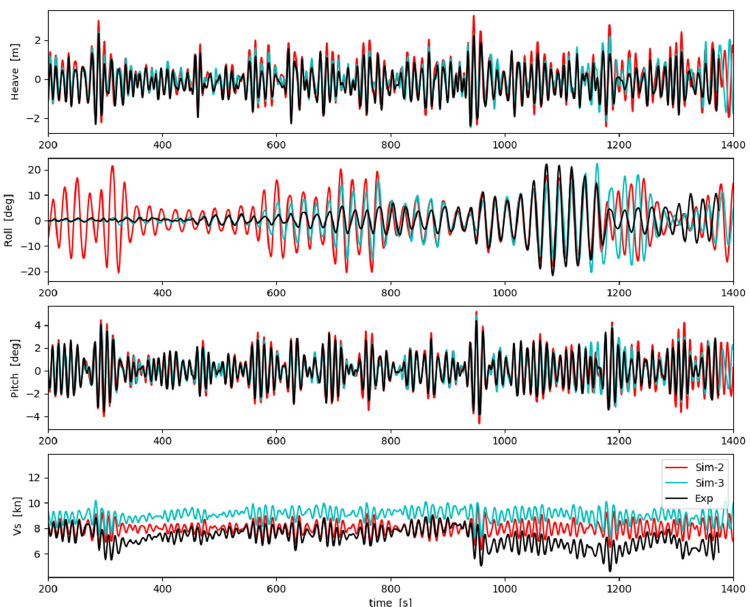
Figure 9. Results of deterministic comparison of a parametric roll event in irregular head seas (Jonswap spectrum, Hs = 7.0 m, Tp = 13.5 s, γ = 3.3), Vs ≈ 8 kn. Heave, roll, pitch and vessel speed from two programs, Sim-2 and Sim-3, are compared to the